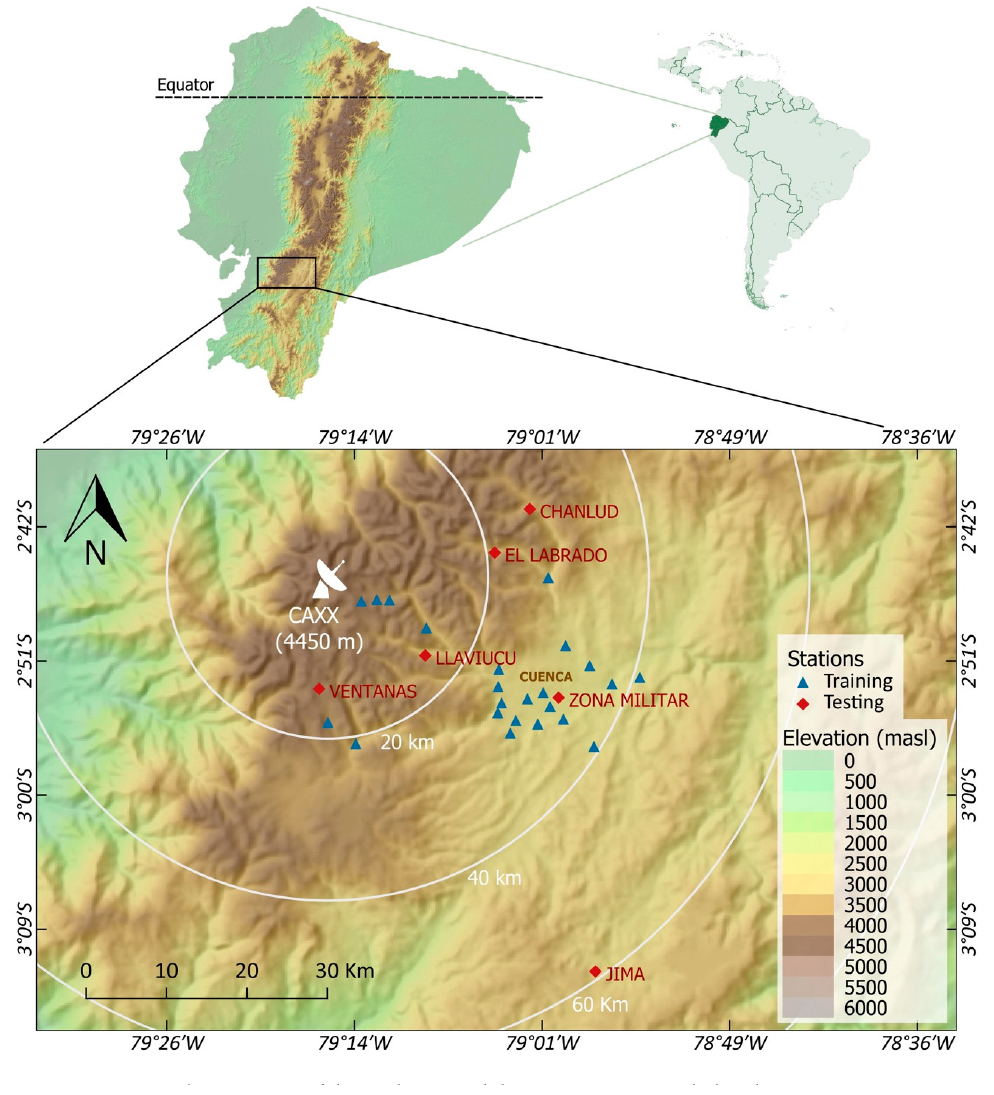
Figure 1. Map of the study site and the rain gauge network distribution.